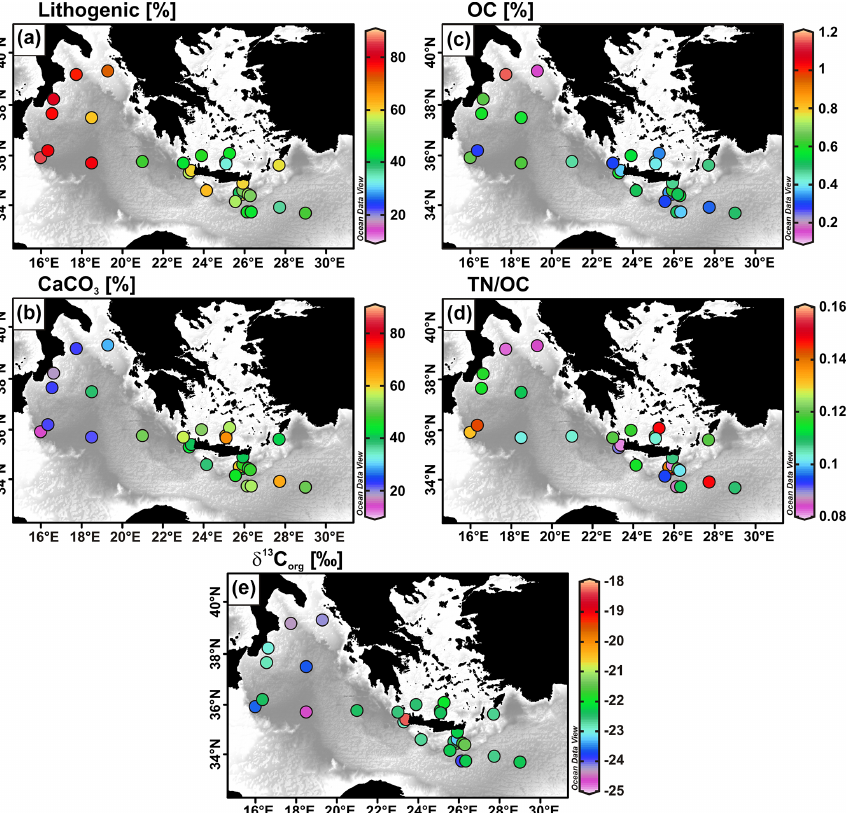
Figure 3. Spatial distribution of (a) lithogenics, (b) CaCO 3 contents, (c) OC contents, (d) molar TN / OC ratios and (e) δ 13 C values in surface sediments of the deep eastern Mediterranean Sea.